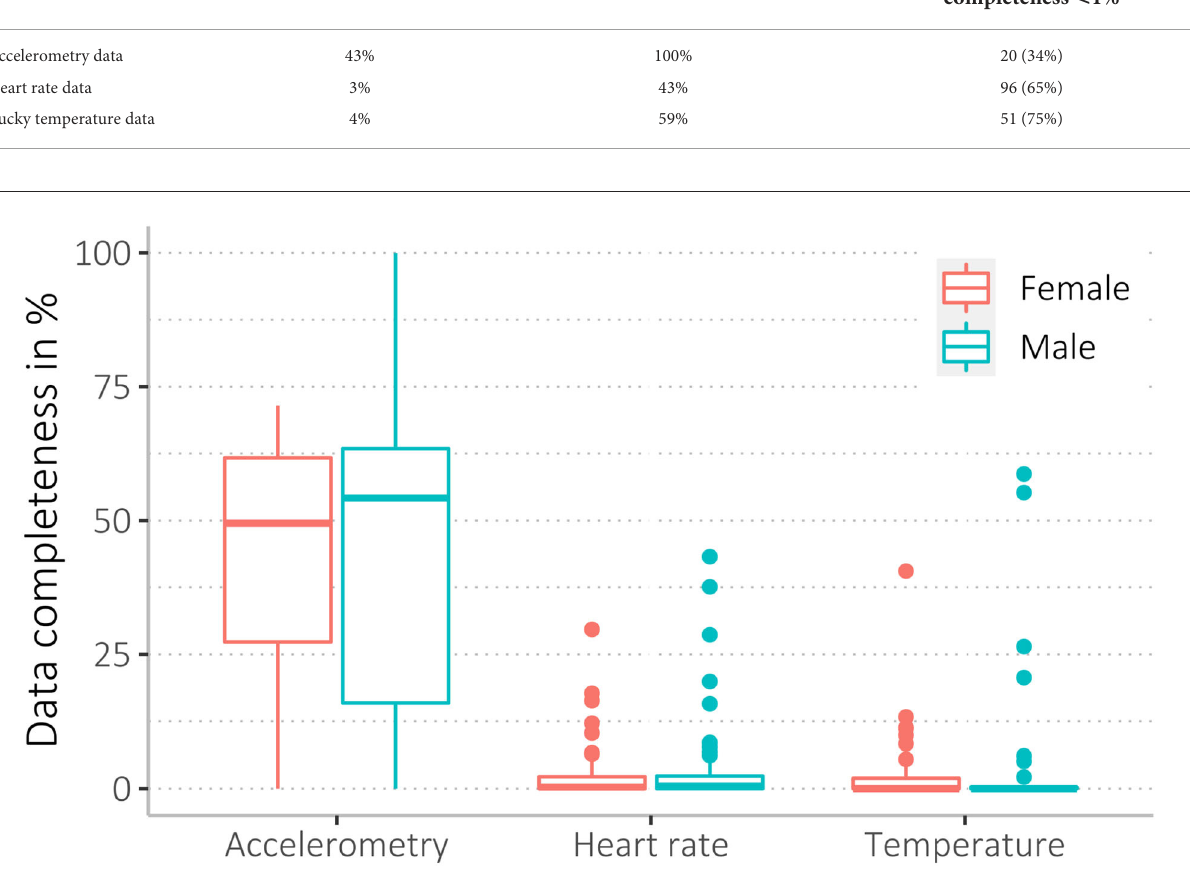
FIGURE4 Data completeness of female and male participants regarding the three data sources (accelerometry, heart rate, and